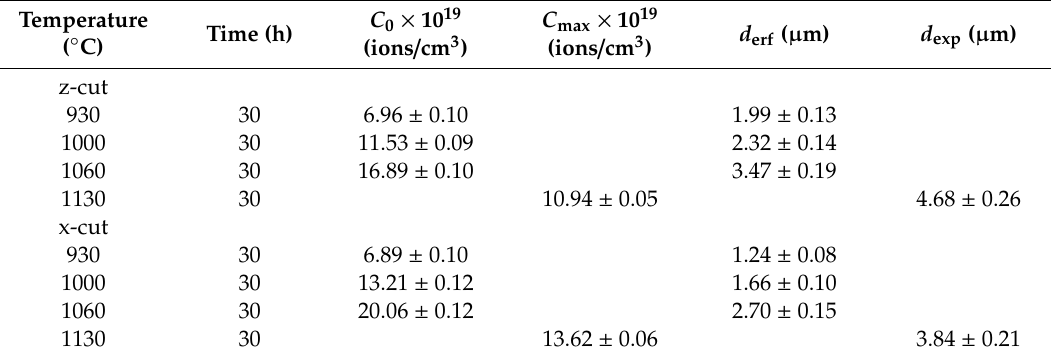
Figure 4. SNMS depth profiles of Yb in LiNbO 3 for in-diffused layers with an initial thickness of 20 nm annealed for 30 h at 1130 °C for different cut directions. Table 1. Parameters obtained for the Yb diffusion in LiNbO 3 .